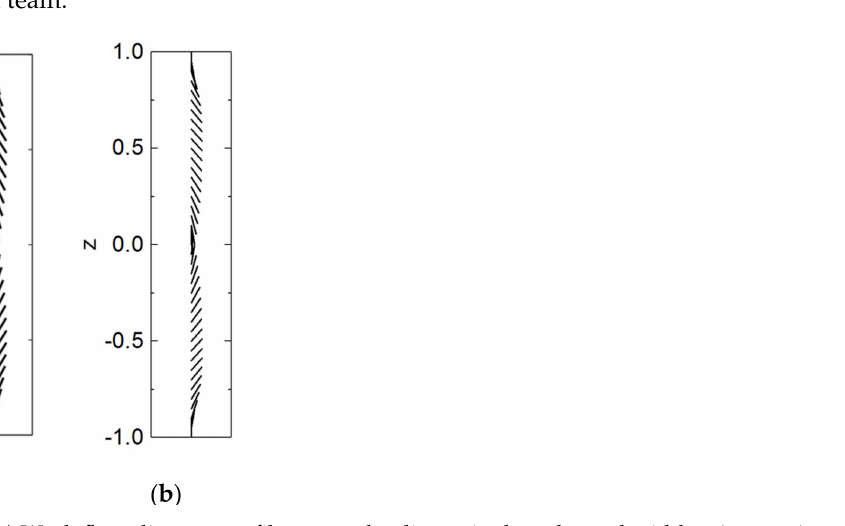
Figure 3. ( a ) Weak flow director profile across the dimensionless channel width − 1 ≤ z ≤ 1 under strong anchoring and g = 25 (Anderson, T. G. et al., 2015). ( b ) The calculated director profile of strong anchoring at g =